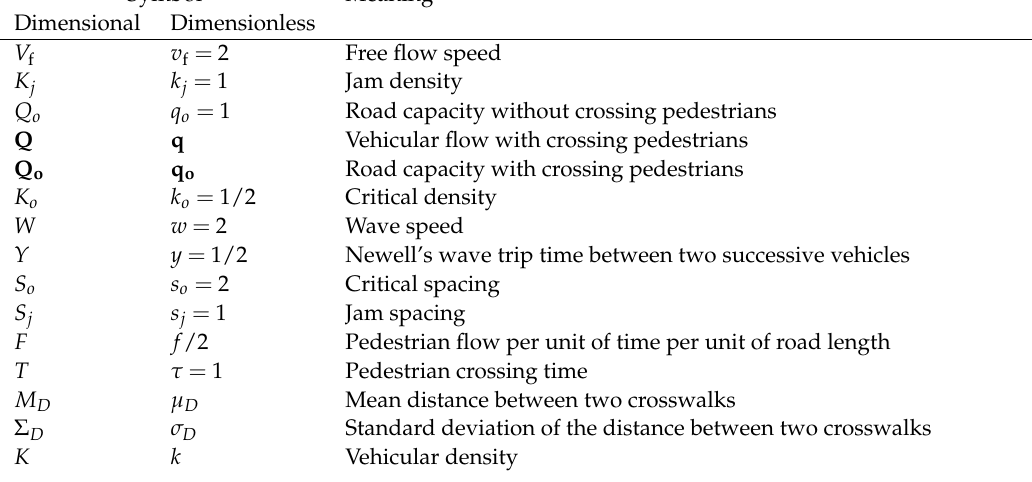
Table 2. The symbols and their meaning. Capitals denote dimensional variables and lowercase letters dimensionless variables. Boldface letters indicate properties of the road under crossing